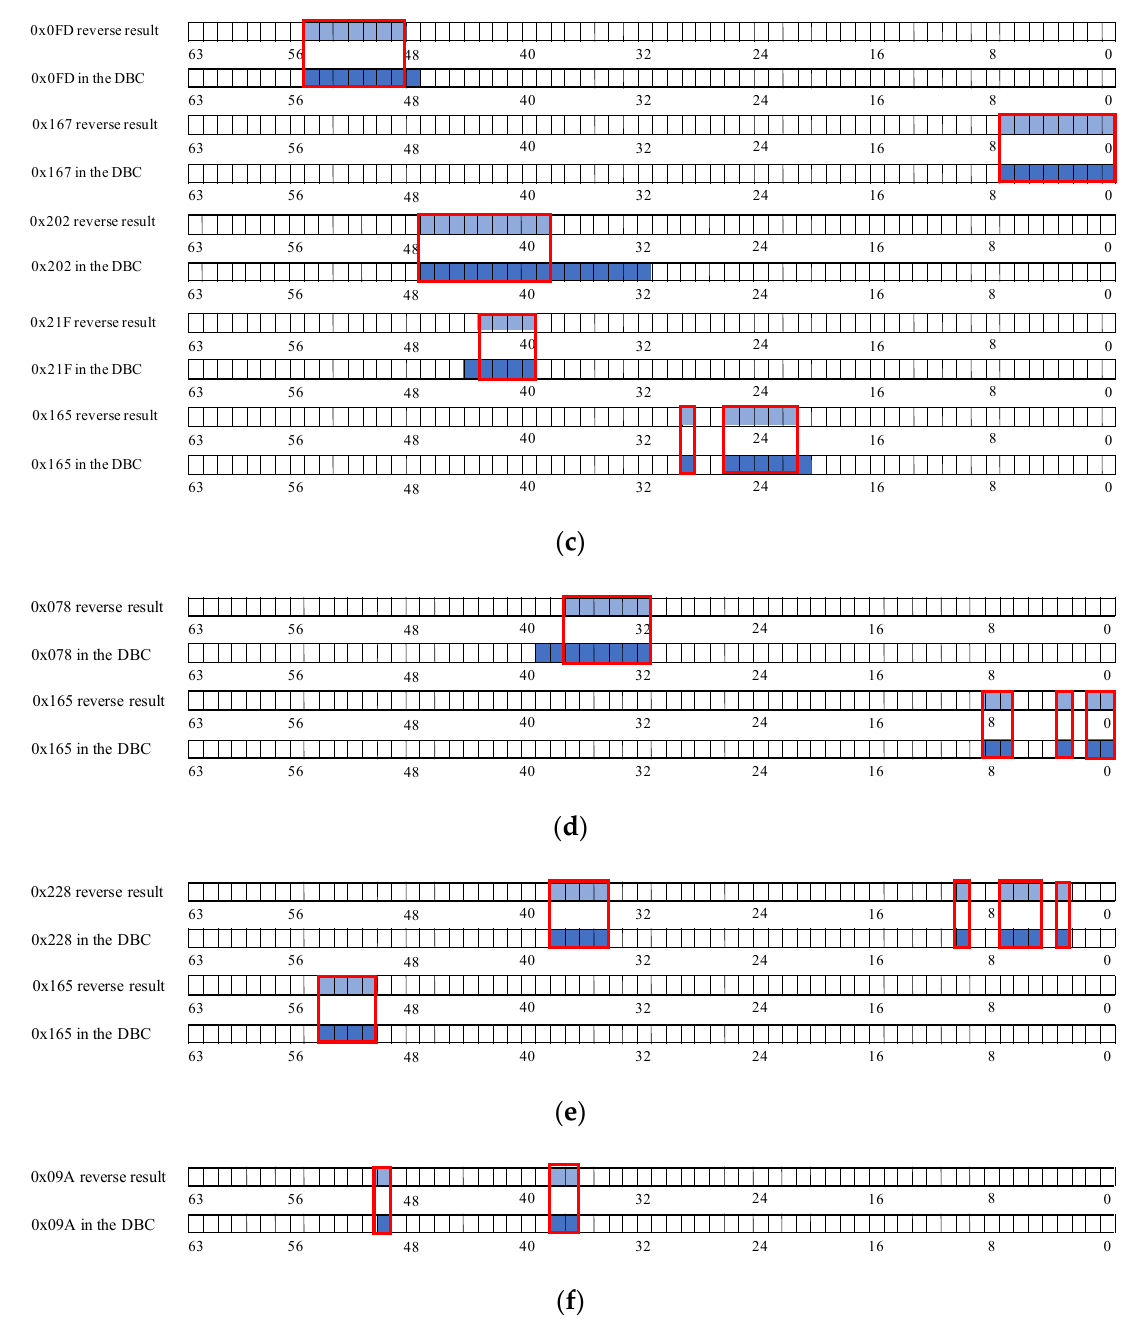
Figure 18. Bit reverse accuracy: ( a ) Speed reverse result; ( b ) Steer reverse result; ( c ) Gas reverse result; ( d ) Brake reverse result; ( e ) Gear reverse result; ( f ) Wiper reverse result. Table 7. Bit reverse result with DBC file description.